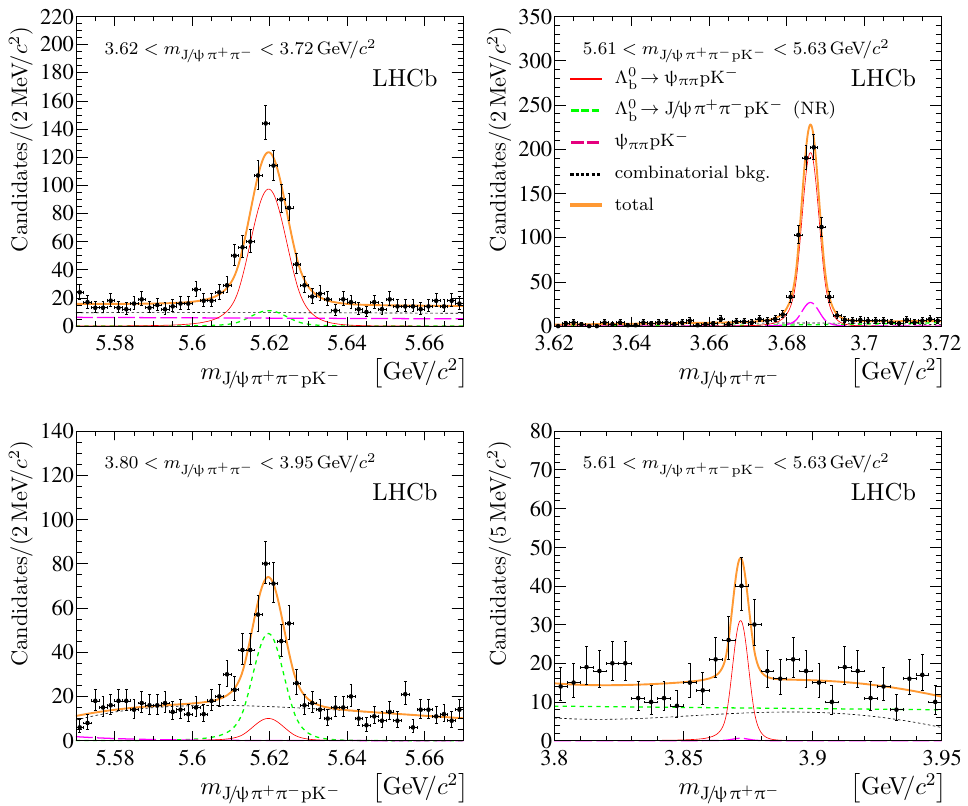
Figure 1 . Projection of the two-dimensional distributions of (left) J = (cid:25) + (cid:25) (cid:0) pK (cid:0) and (right) J = (cid:25) + (cid:25) (cid:0) masses for the (top) (cid:3) 0